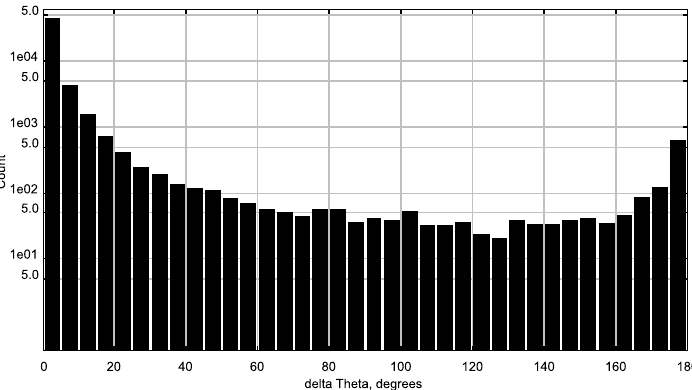
Fig. 2. ∆Θ histogram for the catalogued pairs. Note a concentration of points near the position angle difference of 180 o .